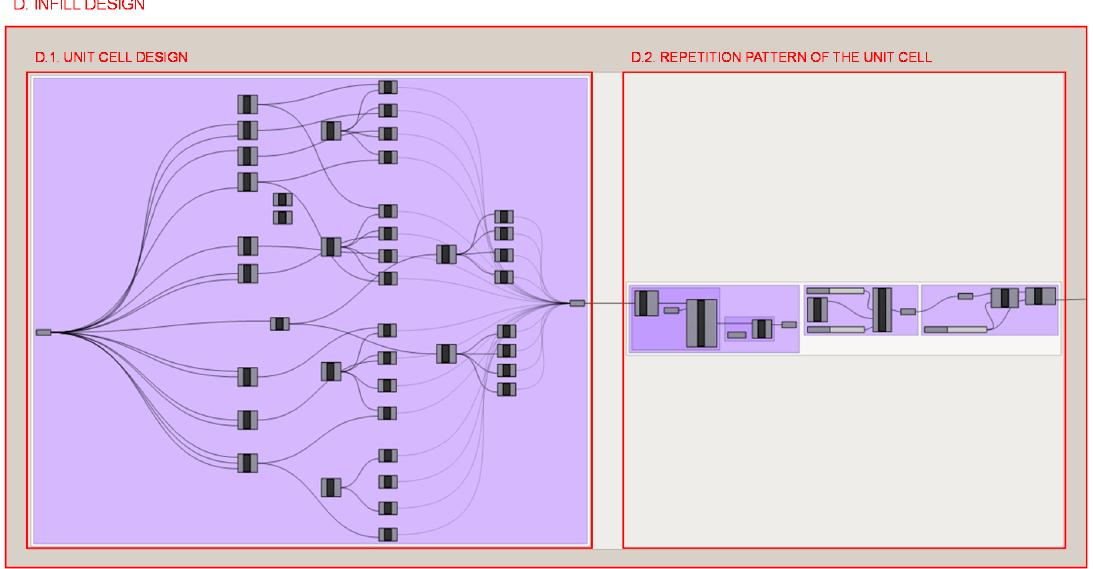
Figure 24. Programming structure definition of the infill geometry.